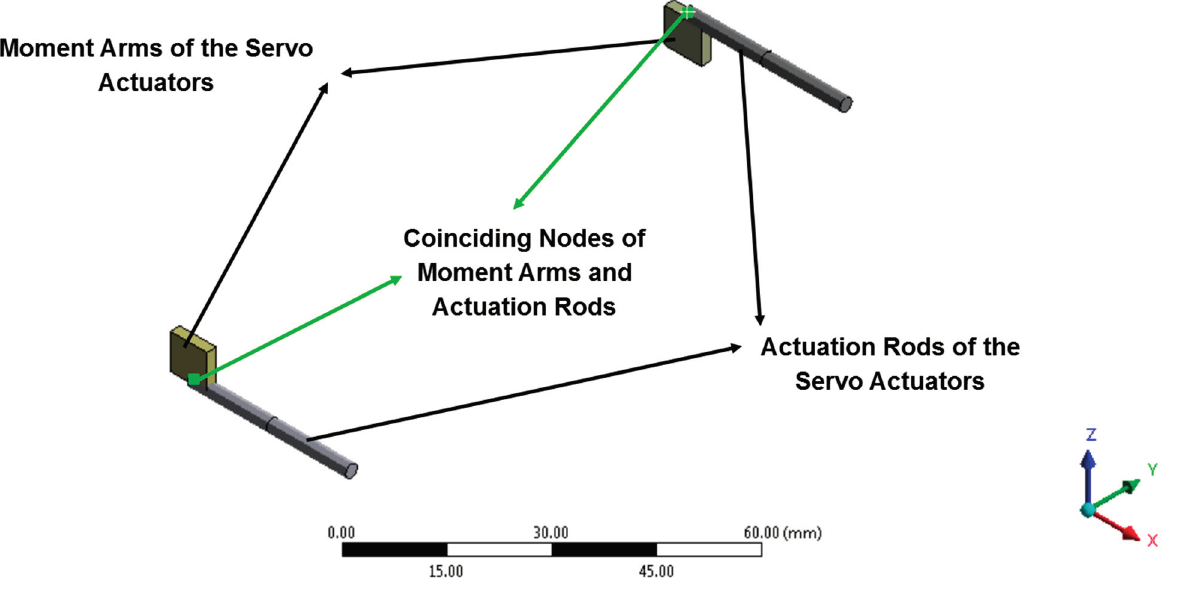
Figure 18. The sample coinciding nodes of servo actuator moment arms and actuation